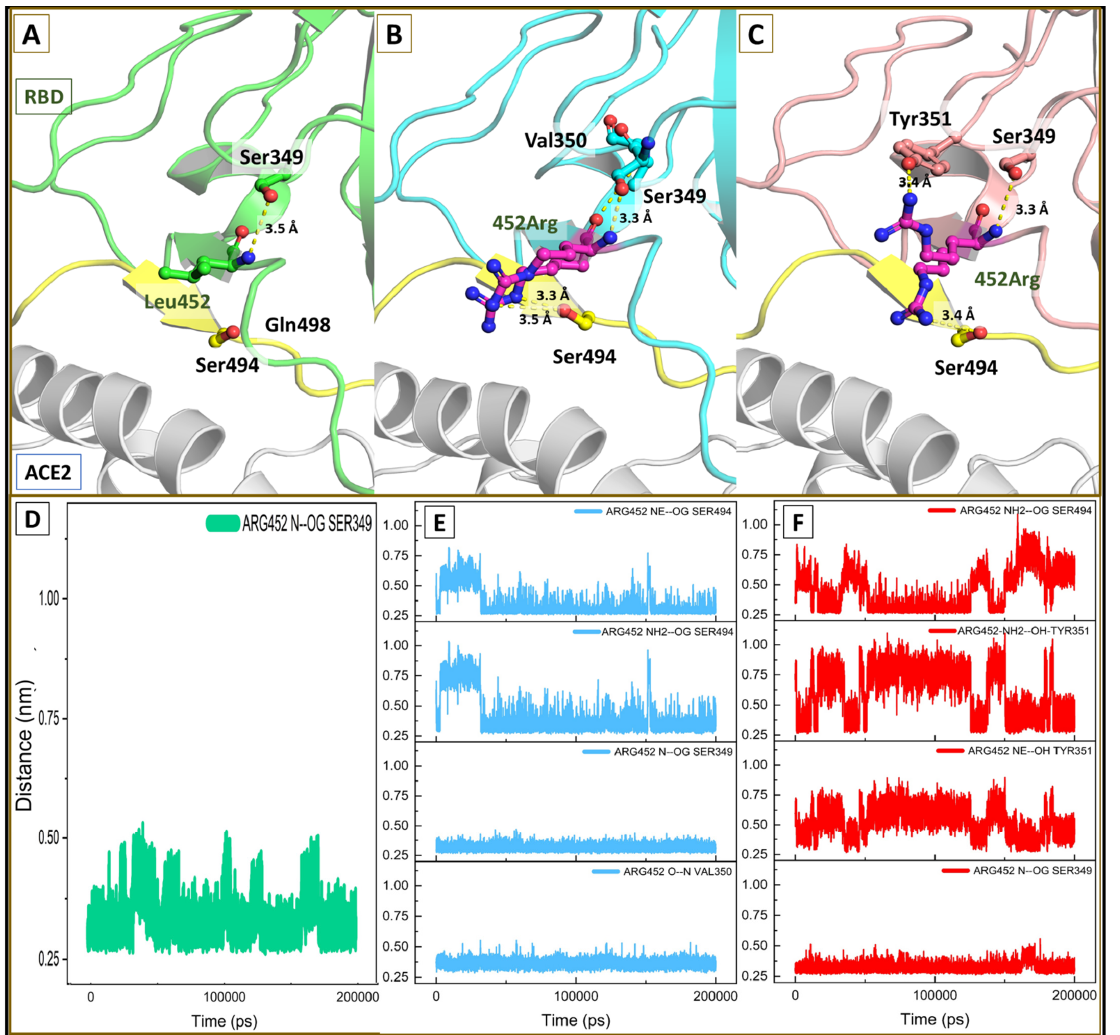
Figure 8. Binding conformation of mutant residue 452. ( A ) Leucine 452 making backbone hydrogen bond interaction with Ser349; ( B , C ) showing hydrogen-bonded interaction of 452Arg in kRBD and dRBD; ( D – F ) plot for hydrogen bond distance through the course of simulation in wtRBD, kRBD and dRBD.